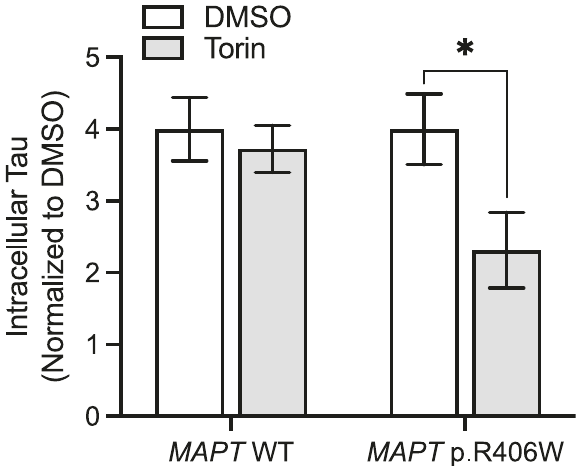
Fig. 8 Torin-1 treatment reduces tau speci fi cally in MAPT p.R406W neurons. iPSC-derived neurons from MAPT p.R406W and isogenic, controls were cultured for 6 weeks prior to treatment with torin-1 or DMSO, control for 5 h. Tau was measured in cells lysates using IP/MS. Graphs represent mean ± SEM. Signi fi cance was determined using an unpaired, t -test. * p <